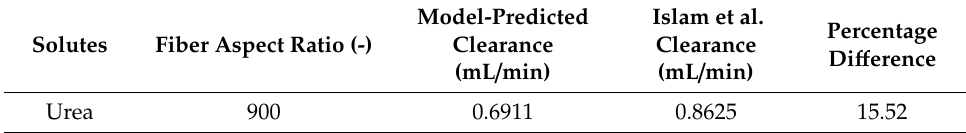
Figure 13. Dimensionless urea clearance rate plotted with the varying fiber aspect ratio. Table 8. Maximum percentage difference of this model with literature data at a varying aspect ratio of dialyzer fiber [22].